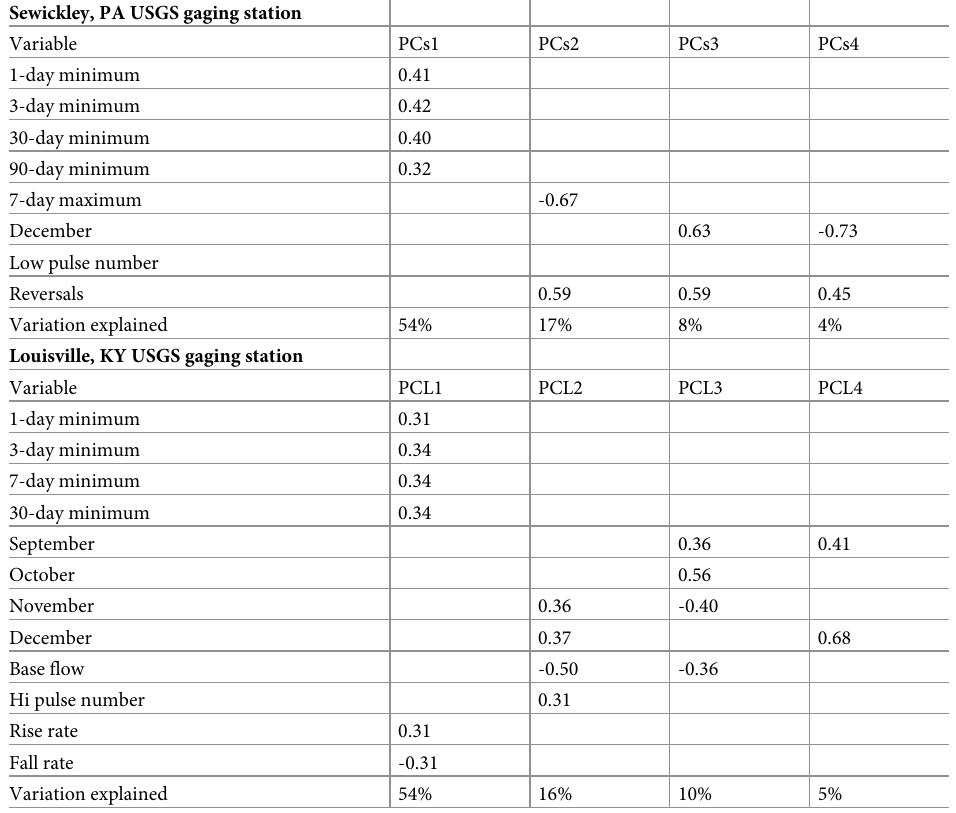
Table 2. Principal components analysis loadings greater than 0.3 for four axes from IHA using data from the Sew- ickley and Louisville USGS gaging stations. Sewickley, PA USGS gaging